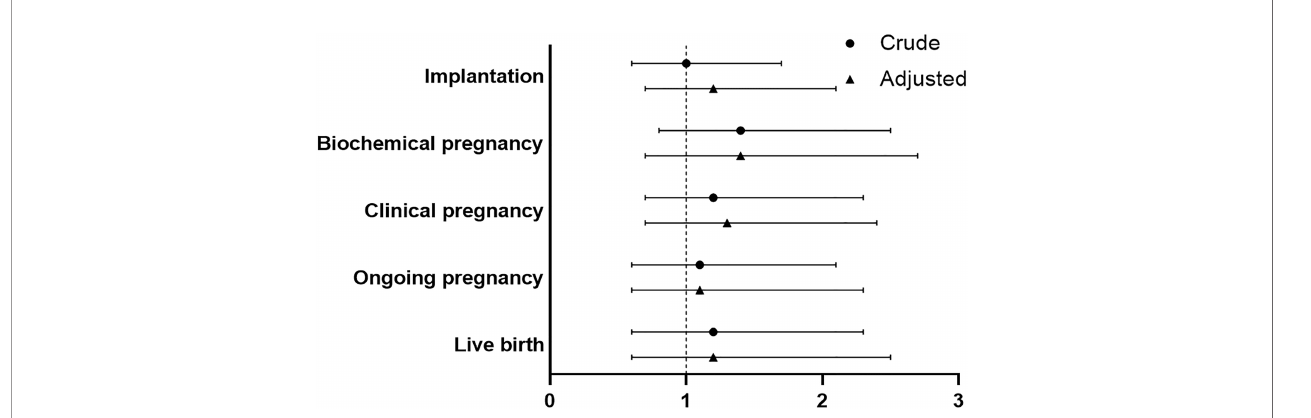
FIGURE 3 | Comparison of reproductive outcomes between PPOS and GnRHant protocol. PPOS, progestin-primed ovarian stimulation; GnRHant, gonadotrophin- releasing hormone antagonist; OR, odds ratio; CI, con fi dence interval. The reference was the PPOS group, adjusted for maternal age, maternal BMI, total antral follicle count, adenomyosis, number of transferred embryos (1 versus 2), stage of embryo, fertilization